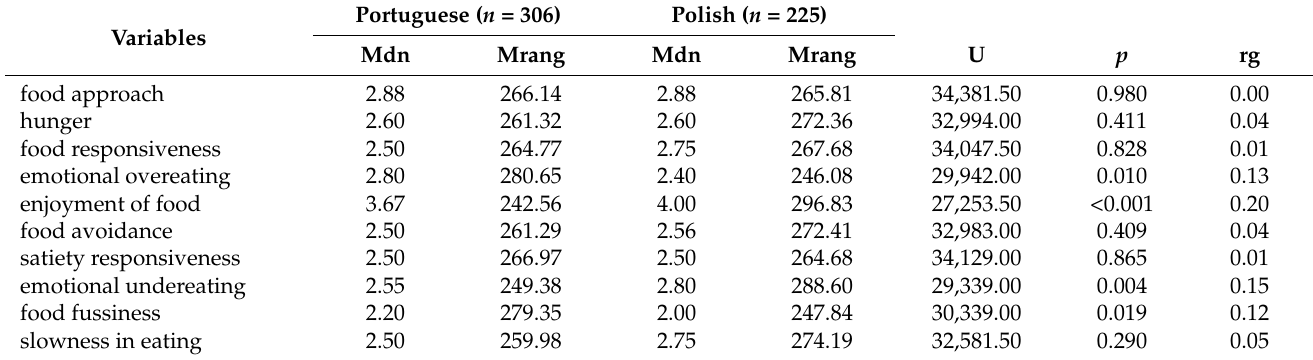
Table 8. Results of Mann–Whitney U test on AEBQ-questionnaire dimensions according to